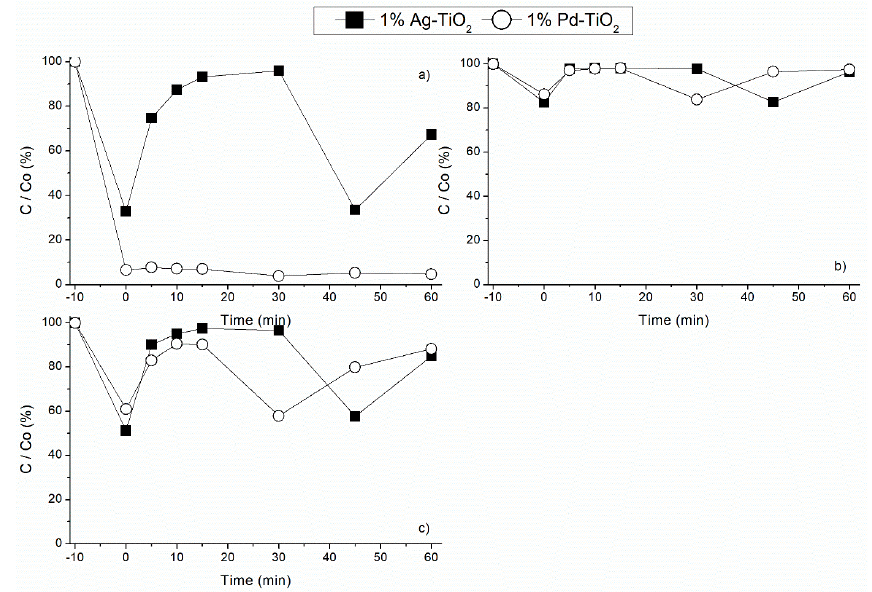
Figure 6. Contaminant (( a ) SMX, ( b ) CBZ and ( c ) LRZ) adsorption on TiO 2 loaded with 1 wt.% Ag or Pd in dark conditions.